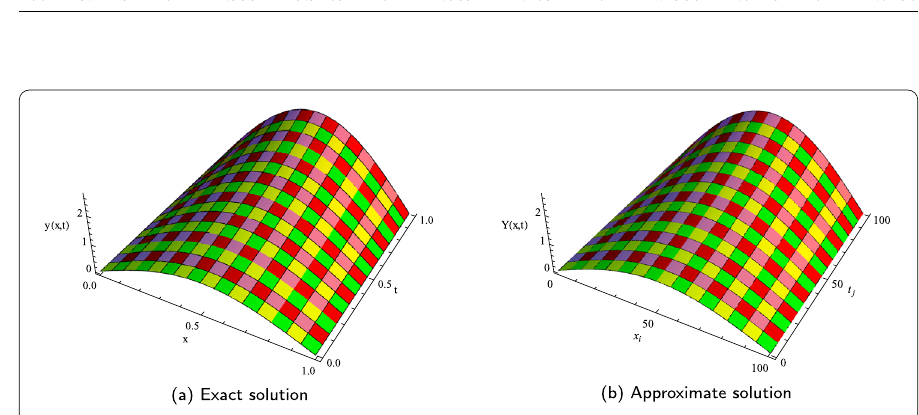
Figure 1 Exact and approximate solution for Problem 1 when n = 100, (cid:12) t = 0.01, and γ = 0.25